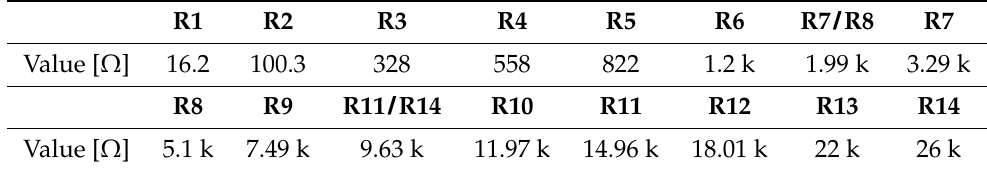
Figure 6. Resistor bank on a bread board. Table 2. Load resistance values used in the